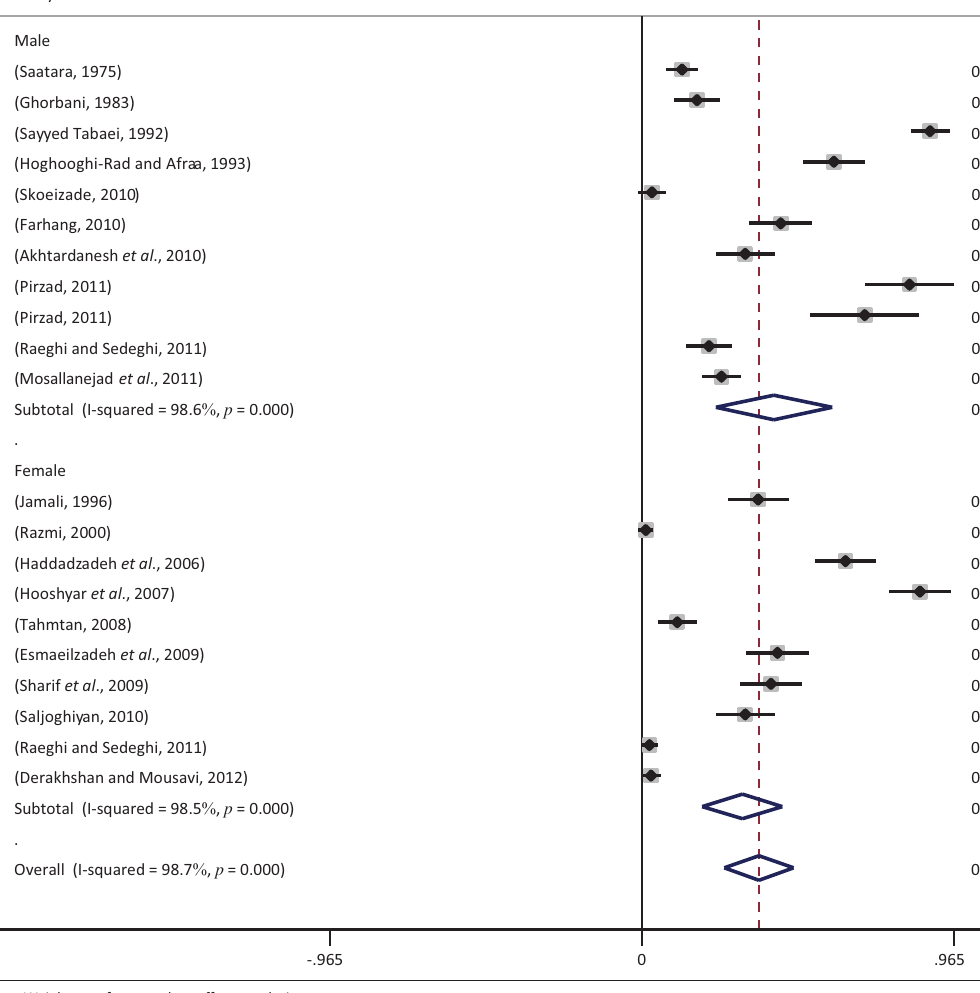
FIGURE 5: Prevalence of seropositivity by sex of cats. TABLE 3: Prevalence of seropositivity by age of cats. Study